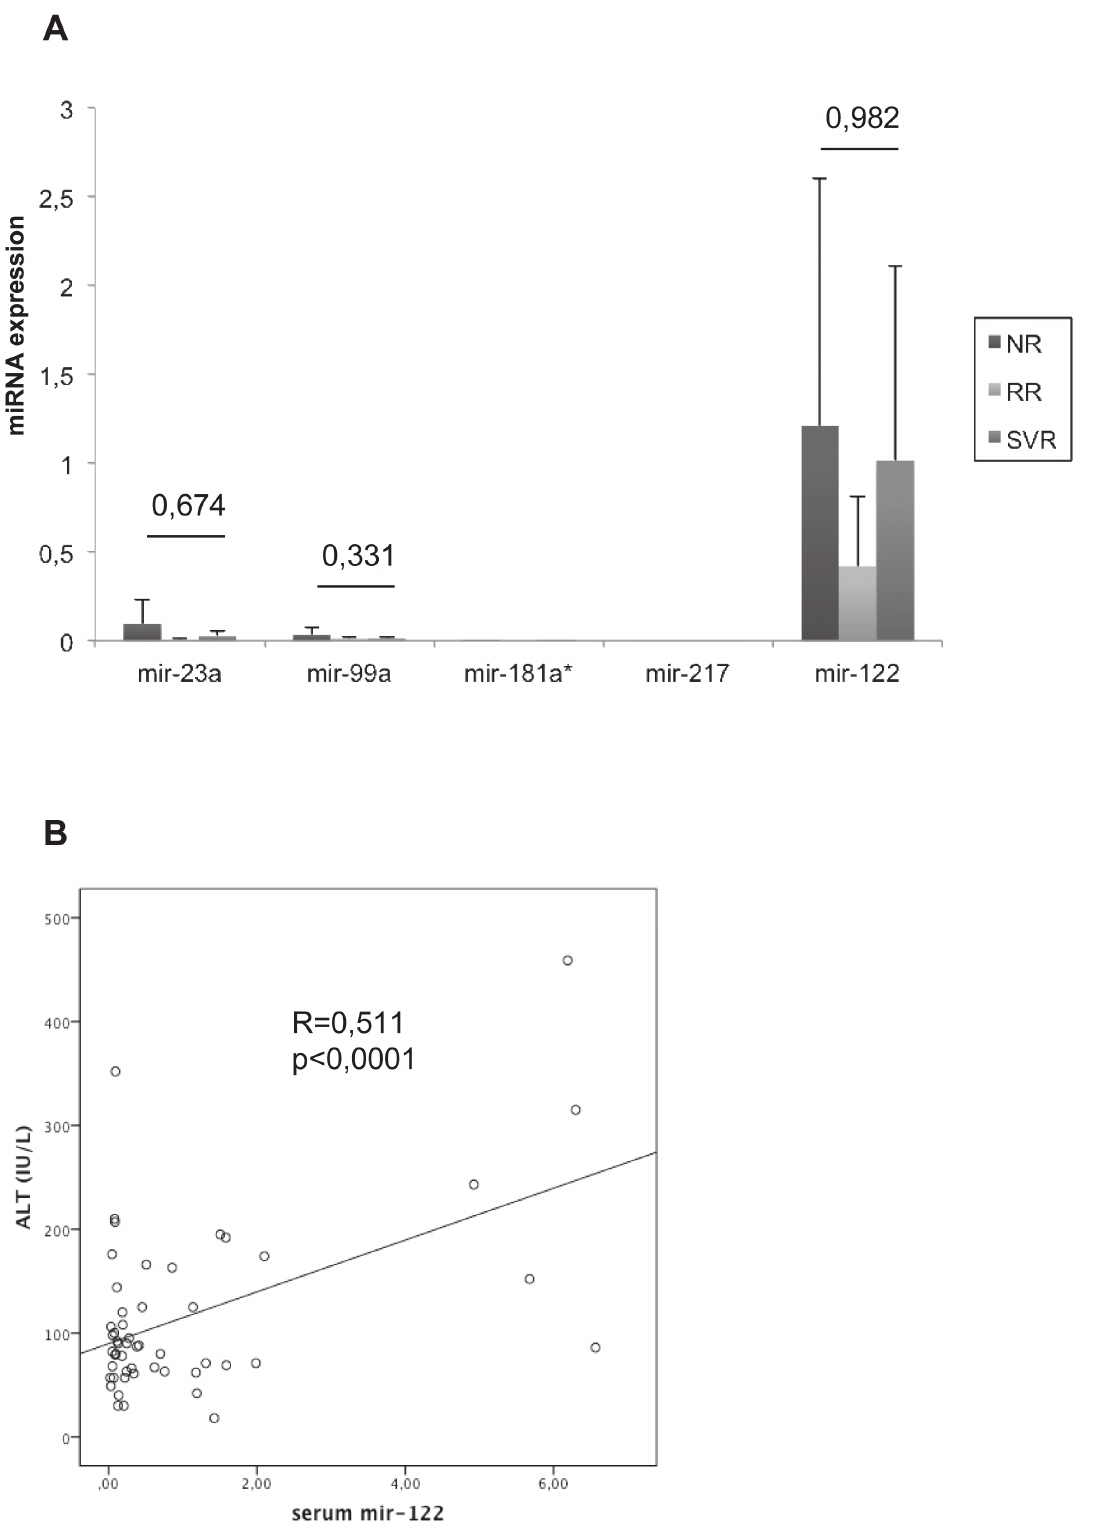
Fig 3. Modification of miRNAs expression in the serum of patients with chronic hepatitis C. 3A- Mir-23a, mir-99a, mir-181a * , mir-217 and mir-122 were detected by RT-q-PCR in 68 serums (NR = 26, RR = 10, RR = 32). The Δ Ct for each miRNAs were calculated and normalized to the Δ Ct value of c . elegans